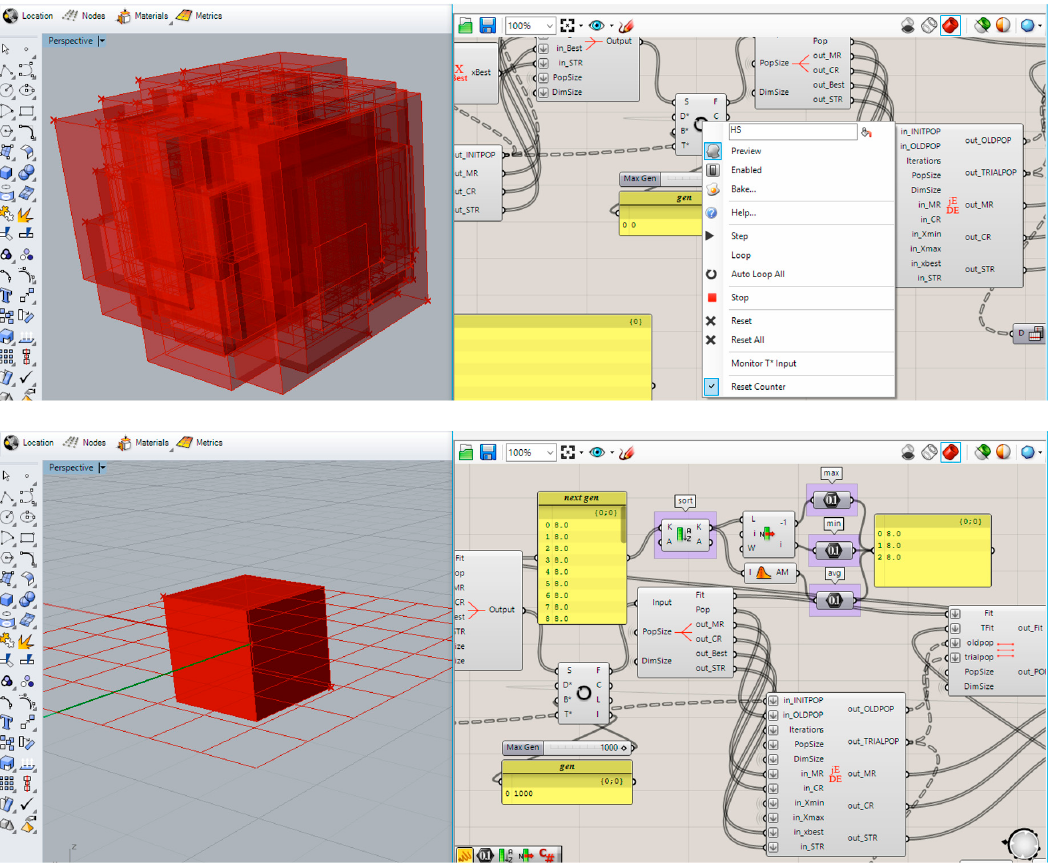
Figure 7. Examples of initial and optimized populations.